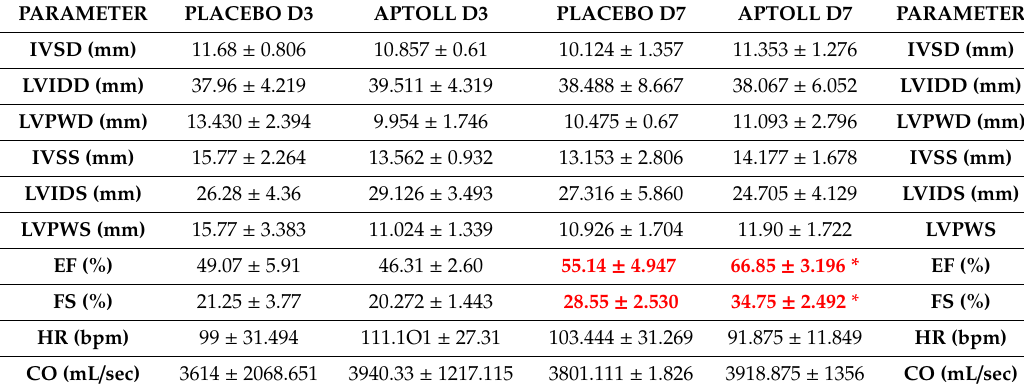
Table 1. Echocardiographic parameters tested by day 3 (D3) and day 7 (D7) after procedure. End diastolic Interventricular septum thickness (IVSD); end diastolic left ventricle internal diameter (LVIDD); end diastolic left ventricular posterior wall thickness (LVPWD); end systolic interventricular septum thickness (IVSS); end systolic left ventricular internal diameter (LVIDS); end systolic left ventricular posterior wall thickness (LVPWS); left ventricle ejection fraction (LVEF); fractional shortening (FS); heart rate (HR); cardiac output (CO). * EF: p < 0.001ApTOLL vs. Placebo. FS: p < 0.003 ApTOLL vs. Placebo.